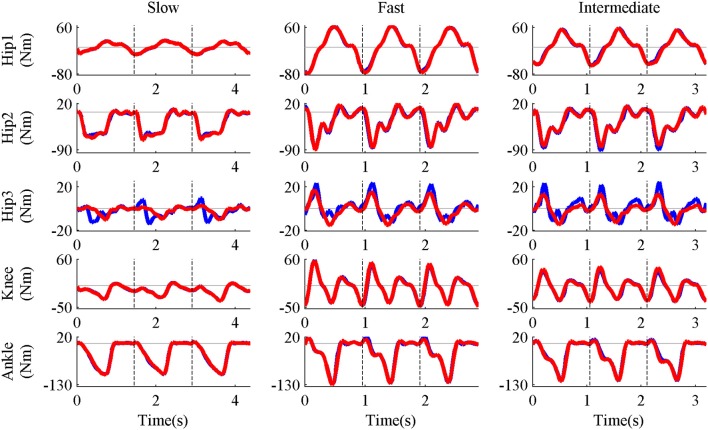
Representative results of synergy constrained torque decomposition (slow and fast speeds) and the reconstruction of joint moments at the intermediate speed by the pure-synergy solution with Nsyn = 4. The figure presents a comparison of experimental (red line) and simulated (blue line) joint moments over all three gait cycles (separated by the black vertical dashed lines in each plot). The five DOFs of the right leg—hip flexion/extension (Hip1), hip adduction/abduction (Hip2), hip internal/external rotation (Hip3), knee extension/flexion (Knee), and ankle dorsiflexion/plantarflexion (Ankle). With each DOF characterized by bi-directional angular movements (written here as motion1/motion2), it must be noted that positive joint moments were in the direction of motion1 while negative moments were in the direction of motion2.